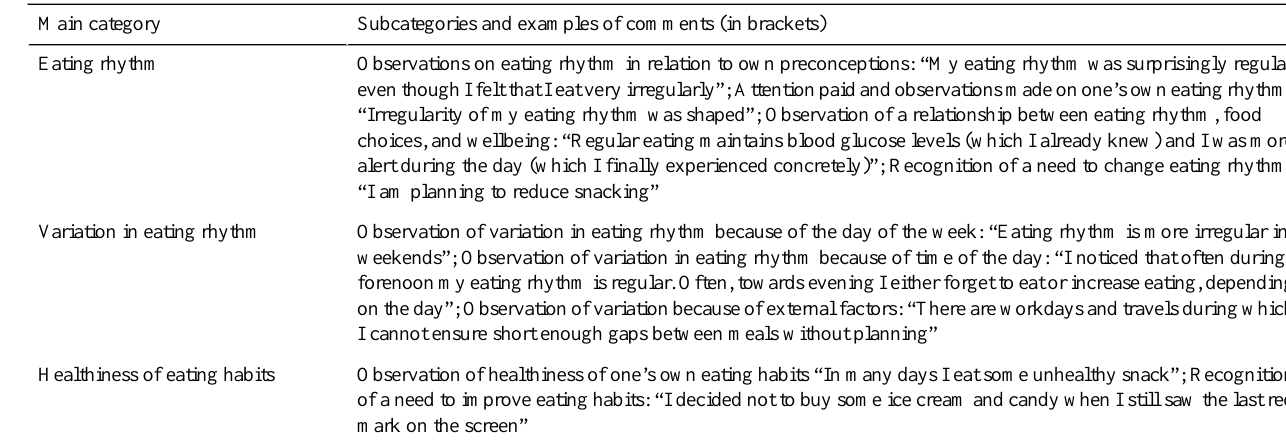
Table 6. Examples of comments of the participants after Button usage in 3 main categories: eating rhythm, variation in eating rhythm, healthiness of eating habits, and their subcategories.